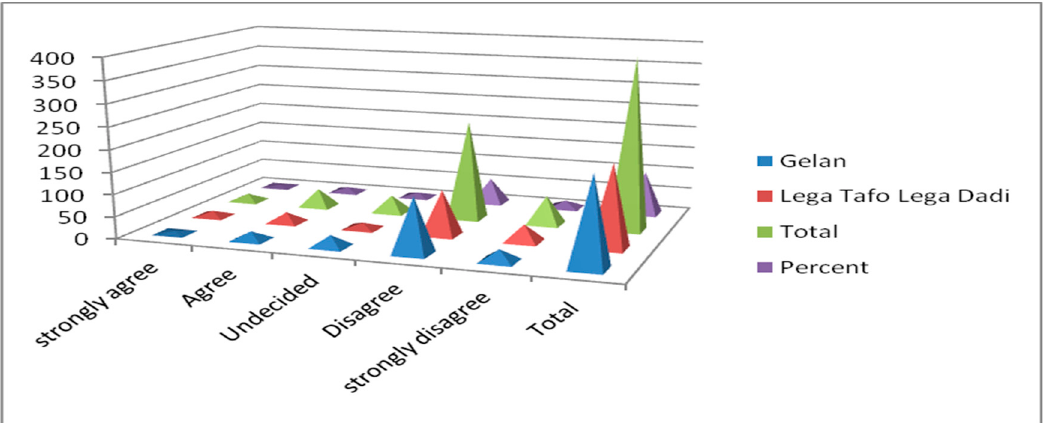
Figure 8. The response rates of household (HH) respondents on the informal settlements in the towns (source: HH survey, 2022).